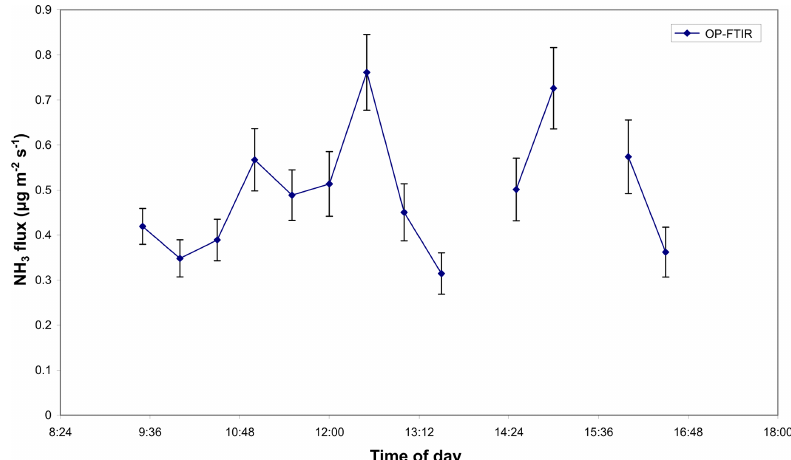
Figure A7. NH 3 fluxes determined from OP-FTIR data and the bLs model in WindTrax at Kyabram on 21 March 2006.